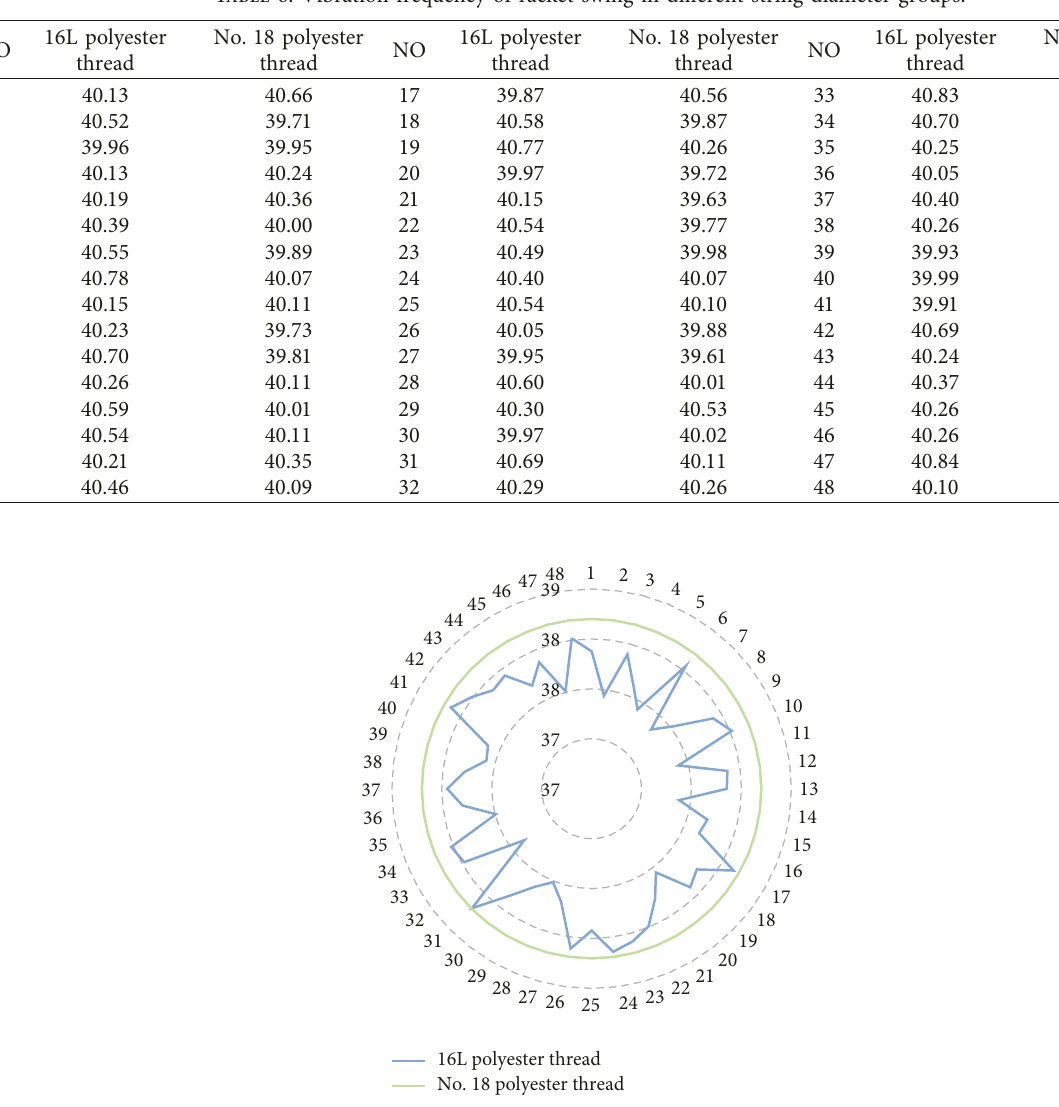
Table 6: Vibration frequency of racket swing in different string diameter groups.